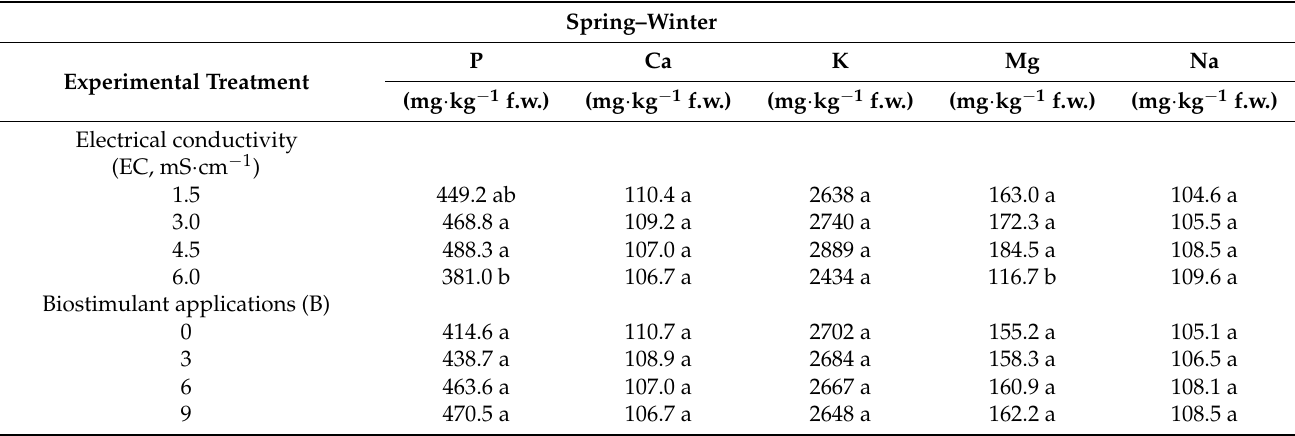
Table 5. Macro-elemental composition of tomato fruits as affected by soil EC and number of biostim- ulant applications.